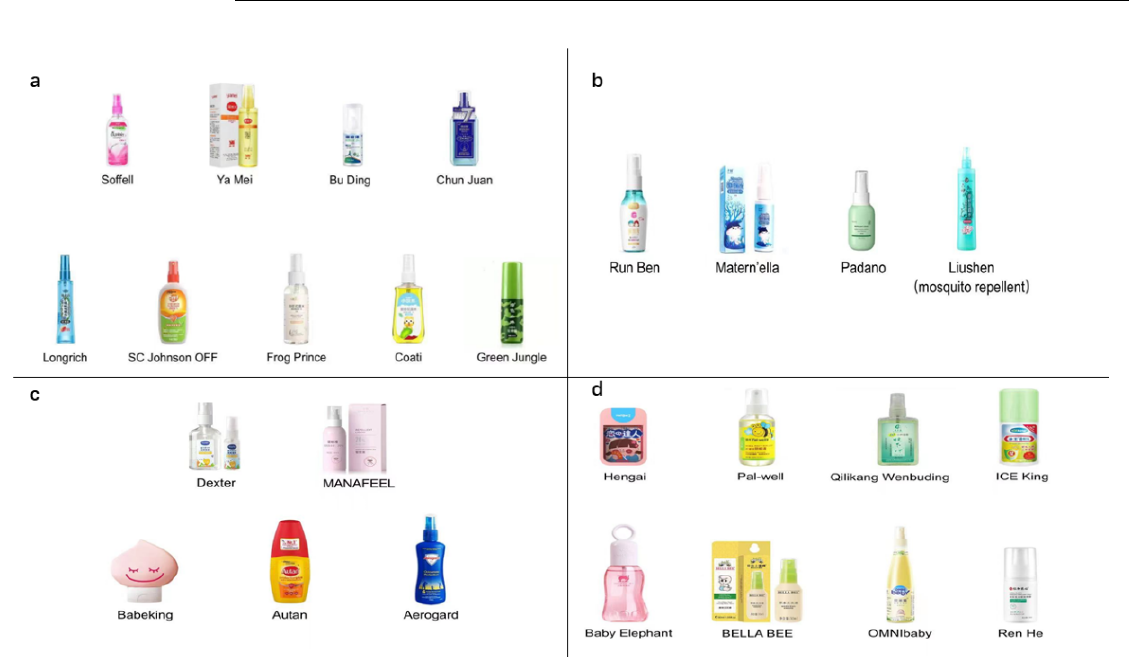
Figure 2. The commercial repellent products selected for testing (26 in total). ( a ) Nine DEET-based repellents; ( b ) four IR3535-based repellents; ( c ) five picaridin-based repellents; ( d ) eight botanical component repellents.